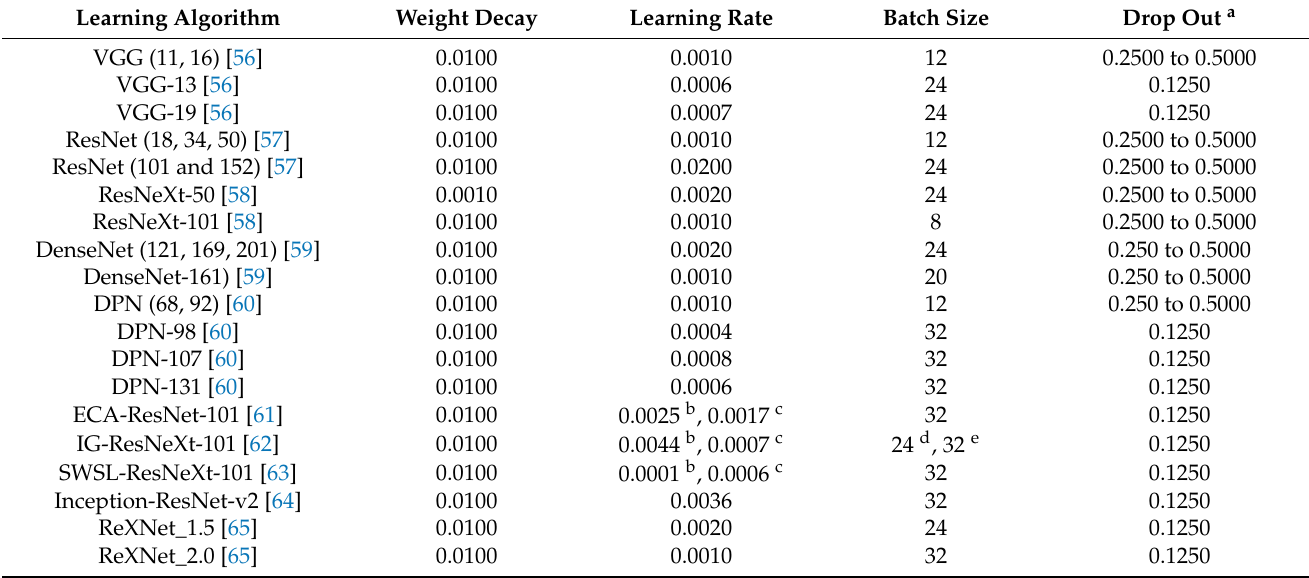
Table 4. Regularization and optimization